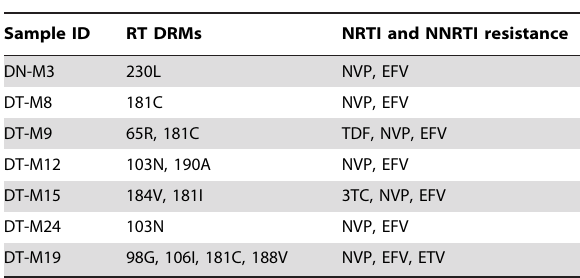
Table 2. Drug resistance mutation (DRM) in RT sequences according to the international list of surveillance drug- resistance mutations (SDRMs) updated in 2009